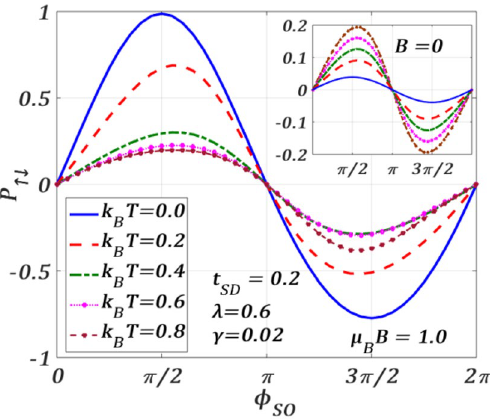
Figure 16. Spin-polarization P 1.0. Inset: at B µ B B =